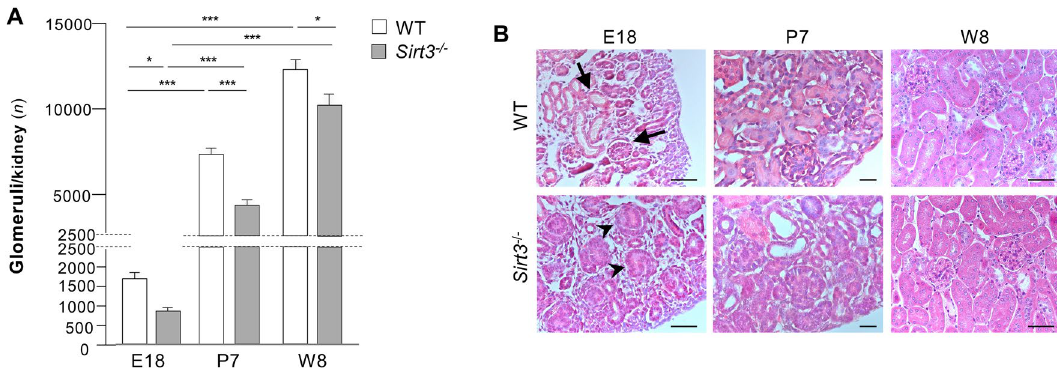
Figure 7. Sirt3 −/− mice exhibit a nephron number deficit. ( A ) Quantification of the number of glomeruli per kidney in WT and Sirt3 −/− mice on E18, postnatal day 7 (P7), and W8 ( n = 6 mice, WT and Sirt3 −/− on E18; n = 8 mice , WT and Sirt3 −/− on P7; n = 6 mice, WT and n = 4 mice, Sirt3 −/− in W8). ( B ) Histologic analysis of kidneys from E18 and postnatal (P7, P12 and W8) WT or Sirt3 −/− mice (representative of n = 3 mice per group). In WT mice, developed glomerulus and tubule are indicated by arrows. In Sirt3 −/− mice, arrowheads indicate immature structures. Scale bars, 20 μm for E18 and W8; 50 μm for P7. Data represent mean ± s.e.m. and were analysed with ANOVA corrected with Bonferroni coefficient. * P < 0.05, and *** P <